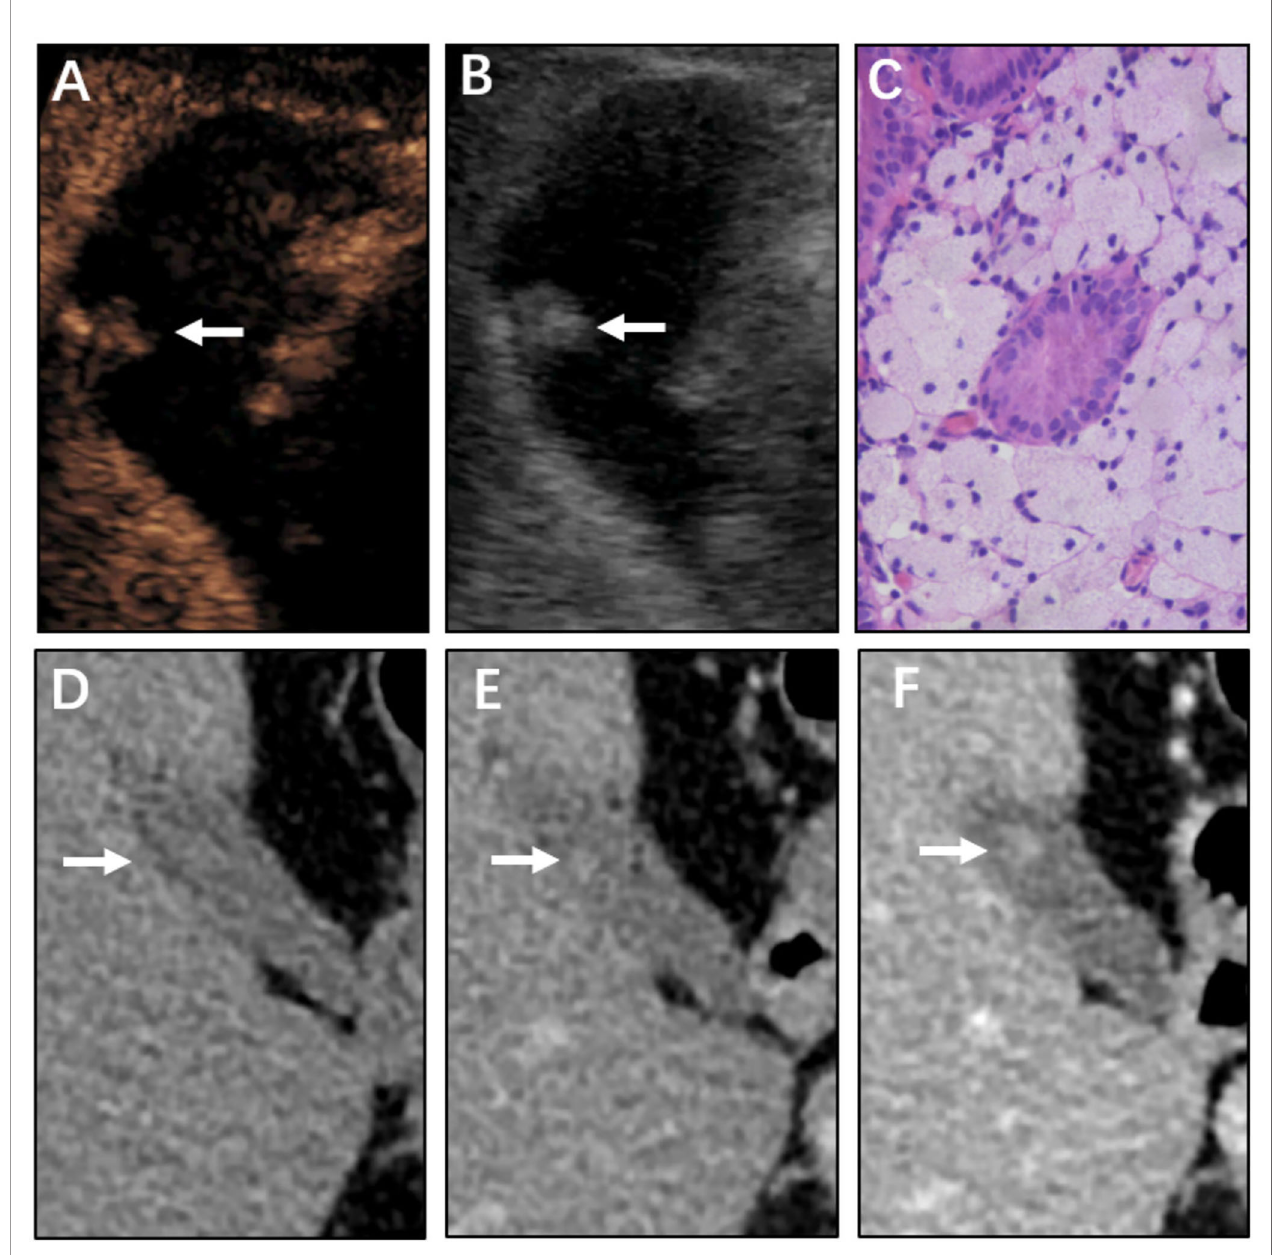
magni fi cation × 400). CT images (D – F) show the same mass in the nonenhanced phase, arterial phase, and portal venous phase, respectively. The mass could barely be detected in the nonenhanced phase. As the contrast agent was perfused, the shape of the mass gradually became